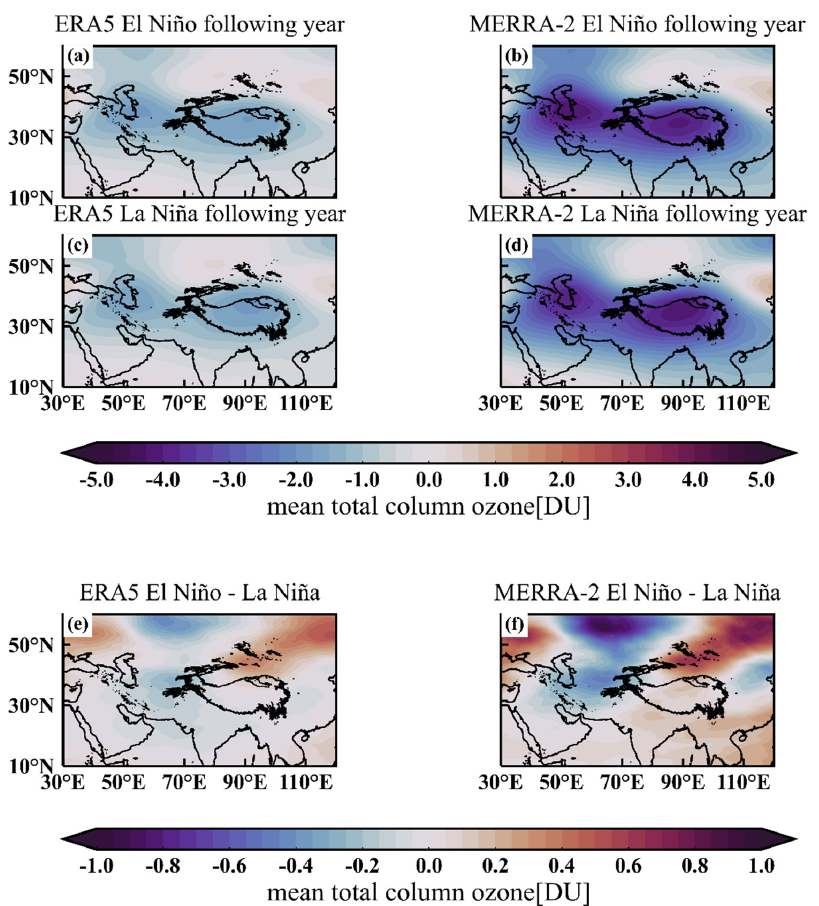
Figure 3. Composite TCO* in the summer following El Niño and La Niña (unit: DU): ( a ) El Niño based on ERA5, ( b ) El Niño based on MERRA − 2, ( c ) La Niña based on ERA5, ( d ) La Niña based on MERRA − 2, ( e ) the difference between El Niño and La Niña based on ERA5, ( f ) the difference between El Niño and La Niña based on MERRA −